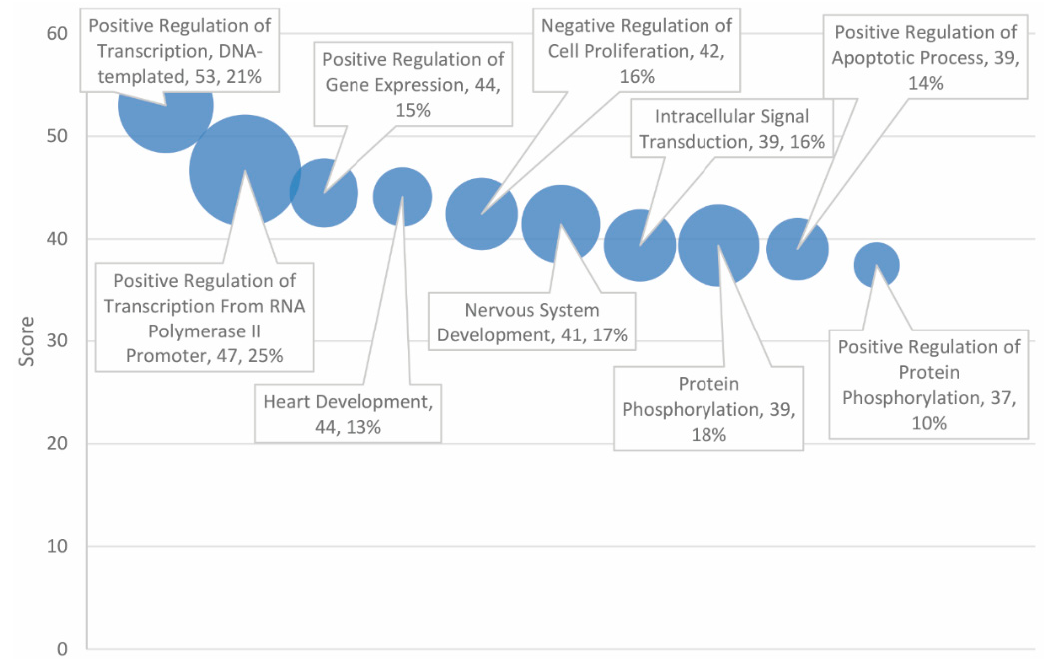
Figure 3. Gene Ontology (GO) biological processes ranked by score and match rate (size of circle) for top ten processes.